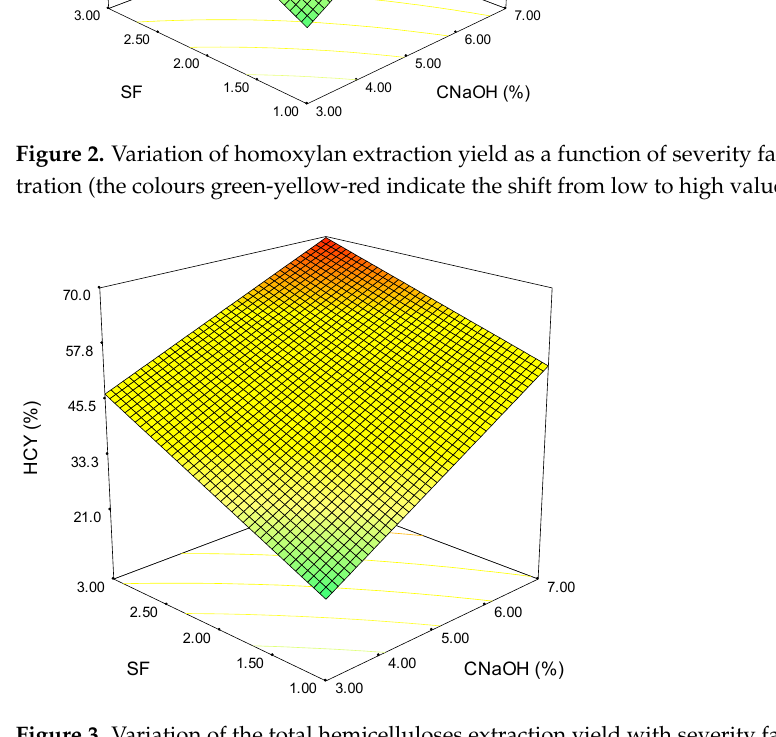
Figure 3. Variation of the total hemicelluloses extraction yield with severity factor and alkali concentration (the colours green-yellow-red indicate the shift from low to high values).